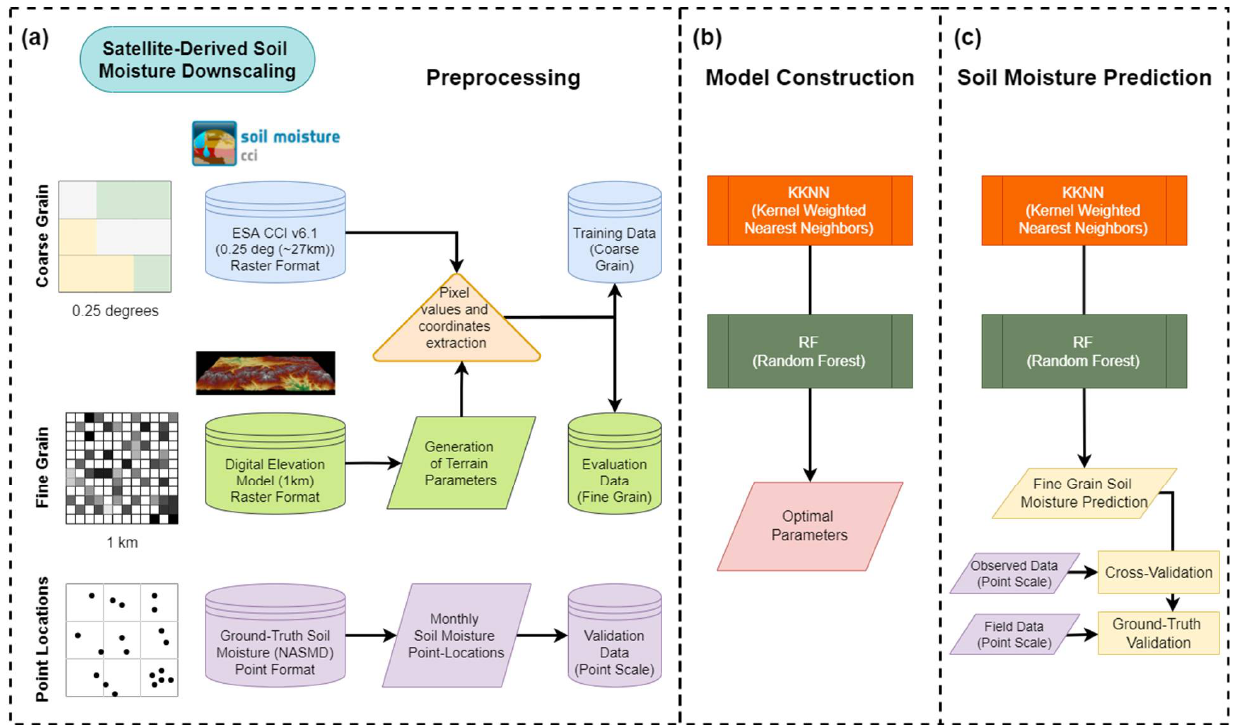
Figure 3. Framework for soil moisture prediction at 1 km spatial resolution derived from coarse resolution ESA-CCI values; ( a ) data preprocessing; ( b ) model construction; ( c ) soil moisture prediction and validation.